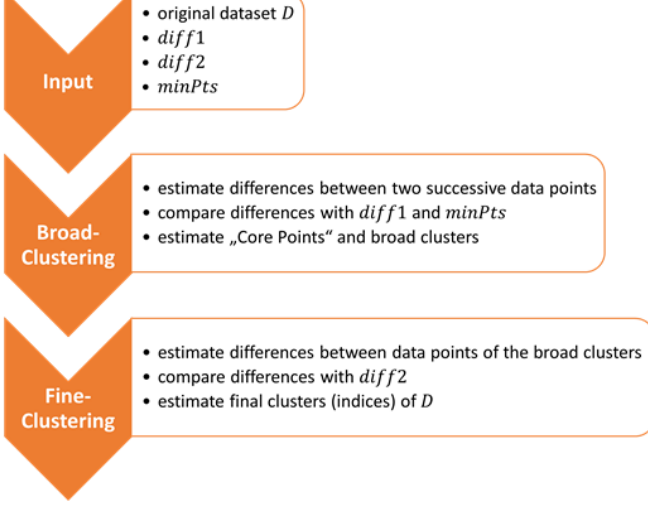
Figure 4. Flowchart of the DBSCAN-derived clustering